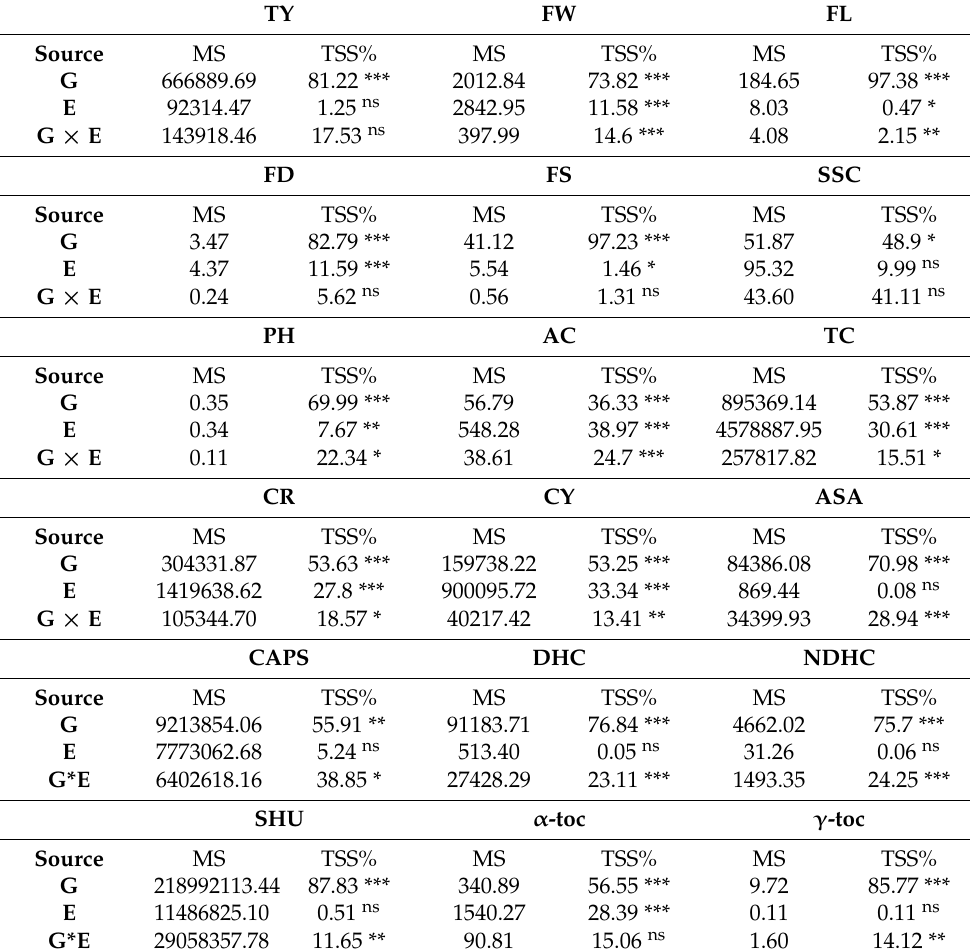
Table 3. Analysis of variance and significant levels for the genotypic (G) and environmental effects due to grow sites (E) for ten chilli pepper cultivars, and the combined effects (G × E) for the traits